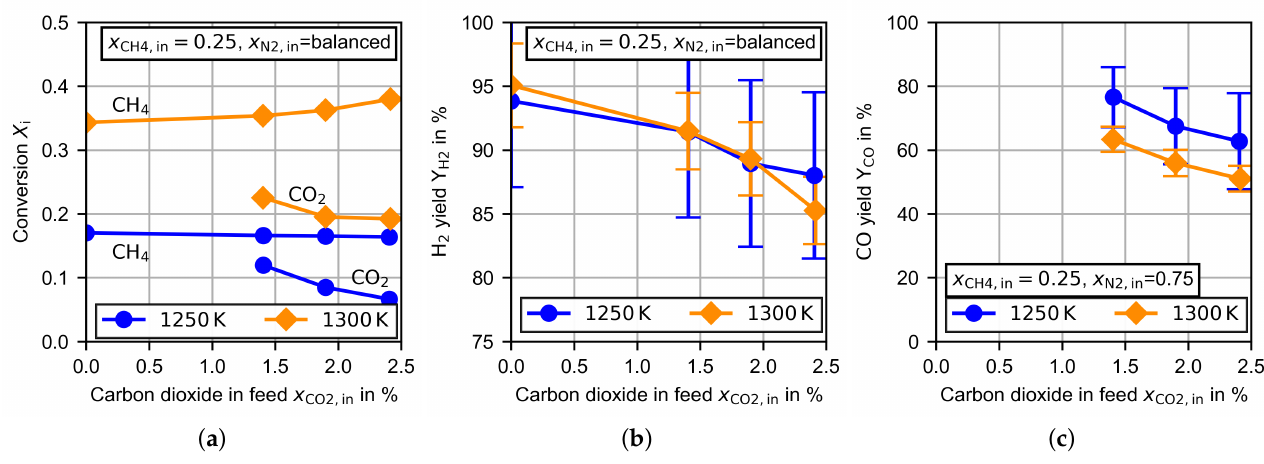
Figure 7. Experimental results for the TDM dependent on the molar fraction of carbon dioxide in the feed at 1250 and 1300K at a constant flow rate of 1Nl/min. ( a ) Methane/carbon dioxide conversion, ( b ) hydrogen yield and ( c ) carbon monoxide